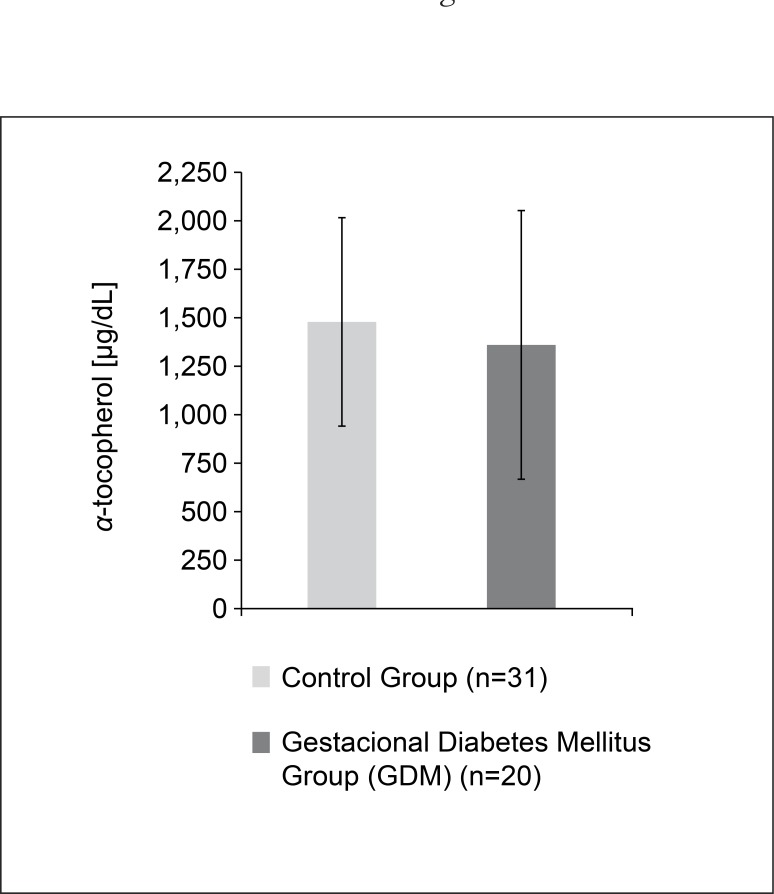
Concentração de a-tocoferol no colostro de lactantes do Grupo Controle e
do Grupo de Diabetes Melito Gestacional